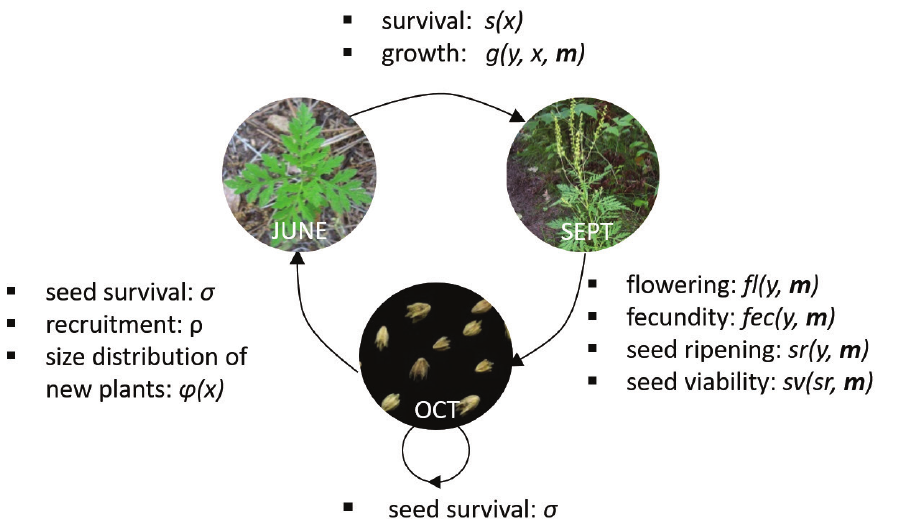
Figure 1. Life cycle of the annual plant Ambrosia artemisiifolia . Months indicated are representative for populations in Europe where most new plants have established in June, have developed into seed- producing plants in September and then die while the seeds shed overwinter on or in the soil. The small loop represents (dormant) seeds that do not recruit but stay in the soil until the next year. The vital rates and corresponding parameters in the demographic model are listed for each period. The x represents new plant size in June, y the plant size in September, m the effect of